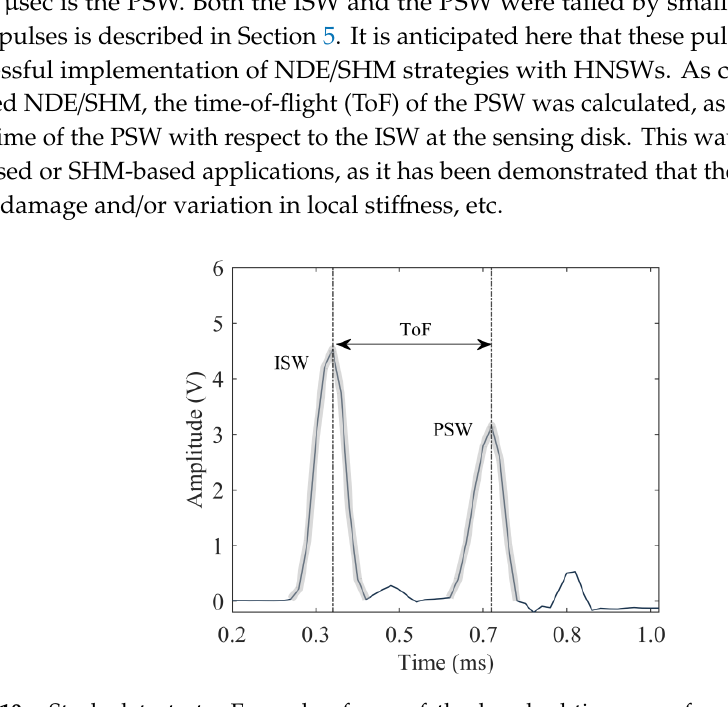
Figure 11. Steel plate test. ( a ) Time-series obtained by averaging the 100-time waveforms measured with the sensor disks. ( b ) Number of occurrences of a given ToF. For each color, the total number of occurrences is 100 . 4.2. Foam Specimen Similar to Figures 11 and 12 presents the results associated with the foam board that was probed with both transducers acting sequentially. For this material, the amplitude of the ISW measured with the PXI is larger than the corresponding amplitude measured with the wireless platform. This trend confirms what seen in Figure 11a but for the latter case the difference was smaller. The origin of such difference is discussed in Section 4.3. Nonetheless, it is important to emphasize that for NDE/SHM applications, the trends of interests are those associated with variations from baseline data when material degradation of damage occurs. As such any transducer to transducer difference in the